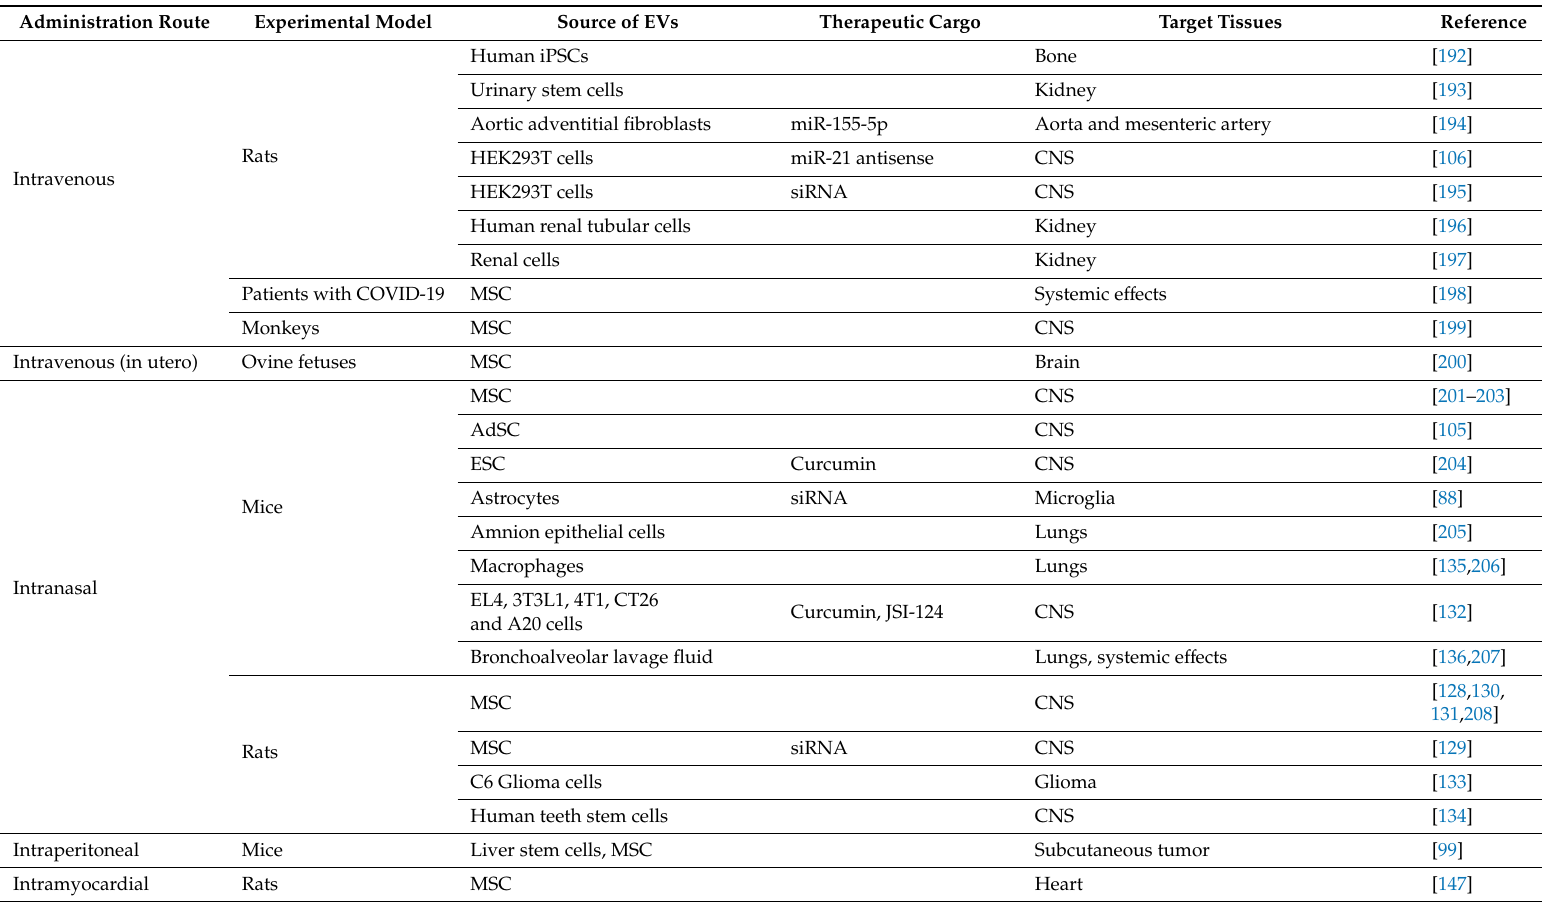
Table 2. Administration routes for EVs in vivo. Detailed are di ff erent studies using in vivo models where EVs were administered. Described are the administration routes, the experimental model, the source of EVs, the therapeutic cargo (when known), and the target tissue of the EVs or the EV-related e ff ects. While in some cases a therapeutic cargo was known, in other cases the EV itself was the therapeutic agent and no particular component of the cargo was specified as responsible for the e ff ect observed. Abbreviations: AdSC: adipose tissue-derived stem cells; CNS: central nervous system; miR: micro RNA; MSC: mesenchymal stem